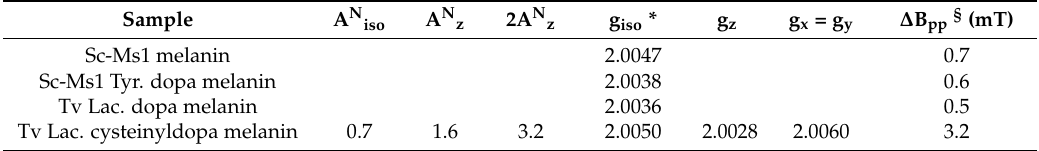
Table 1. Magnetic parameters for the natural and enzymic synthetic melanin